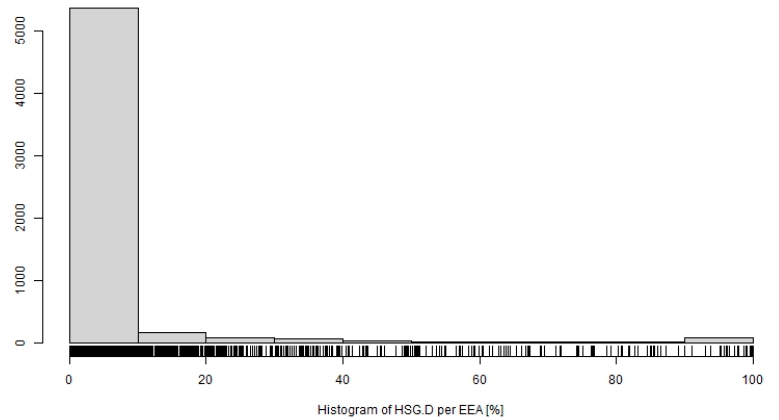
Figure 9. Distribution of EEAs by percentage of HSG (HSG.A, B, C, D). Characteristics of horizontal